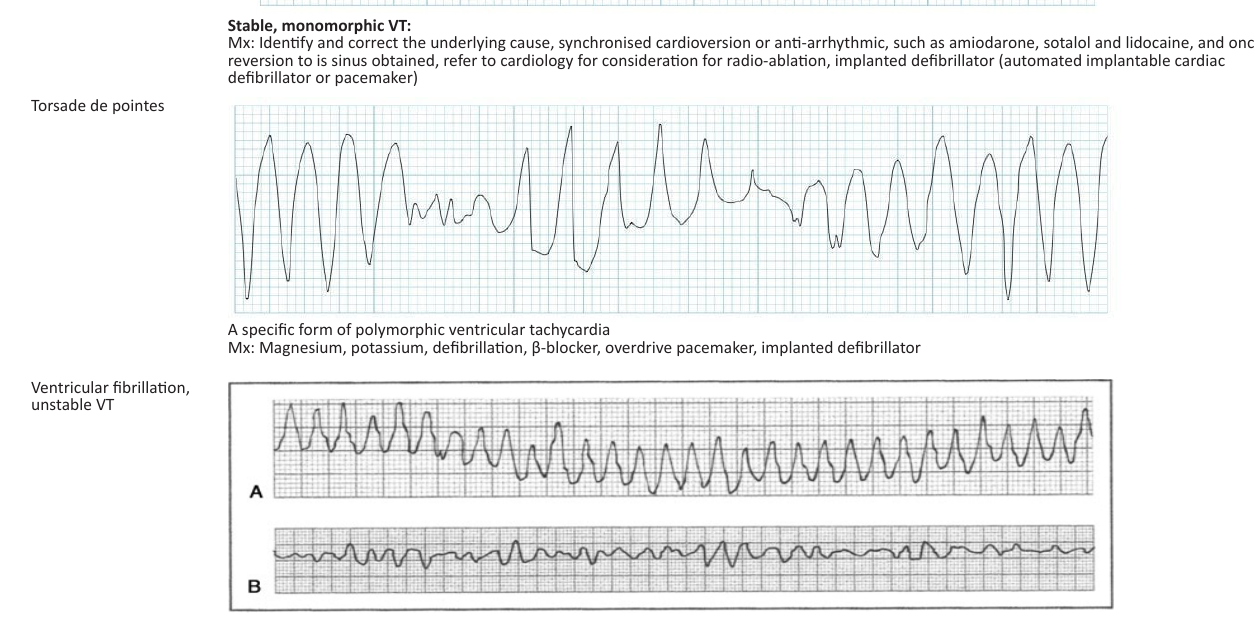
Table 2 continues on the next page